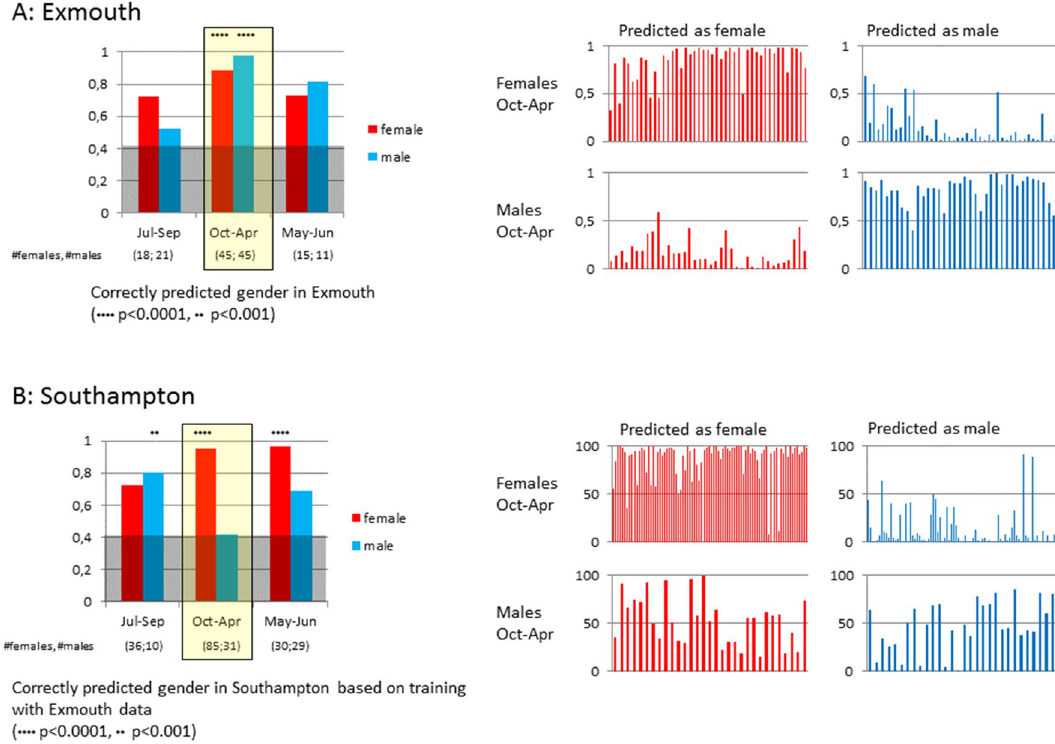
Figure 5. ( A ) Prediction accuracy of sex in Exmouth using support vector machine with 25% and 75% cross validation (left), and prediction of sex for individual mussels (right). ( B ) Prediction accuracies of Southampton mussels (left) and sex prediction for individual mussels in Southampton